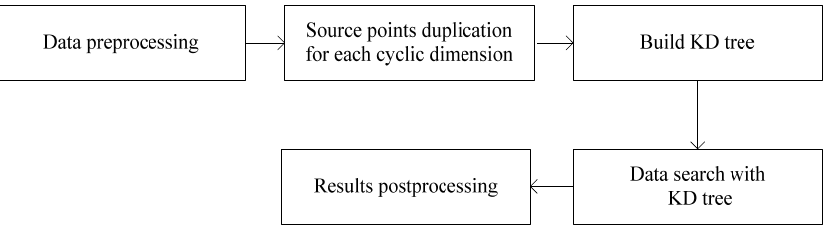
Figure 2. The process of the mirror method based on source points duplication. The process of the mirror method based on target points duplication is shown in Figure 3. Initial works, including data preprocessing, KD tree construction, and